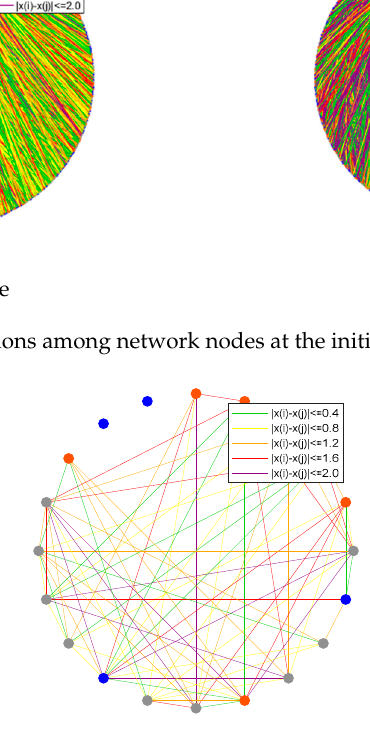
Figure 18. Node connections when N = 20.